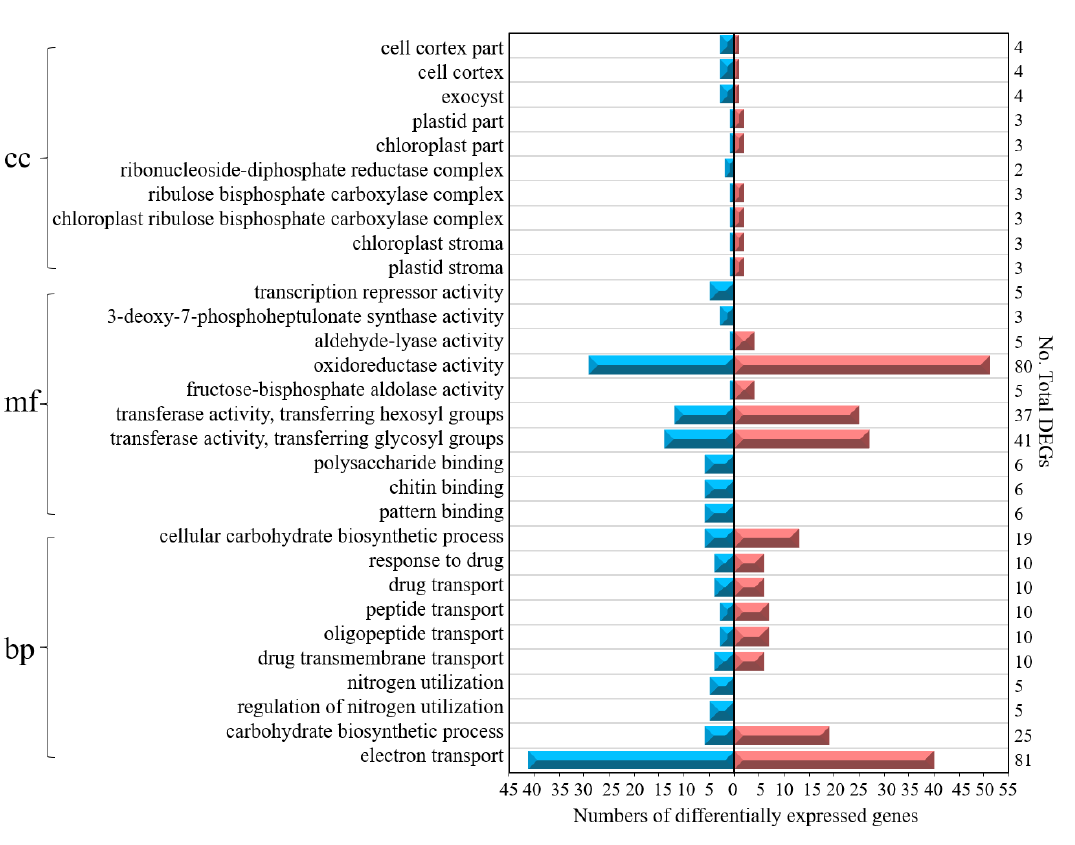
Figure 5. Top ten Gene Ontology (GO) term classifications of the DEGs from six cross-comparisons between the different gene sets. BP — biological process; MF — molecular function; CC — cellular component. The blue color on the left indicates downregulated DEGs, while the red color on the right indicates upregulated DEGs.